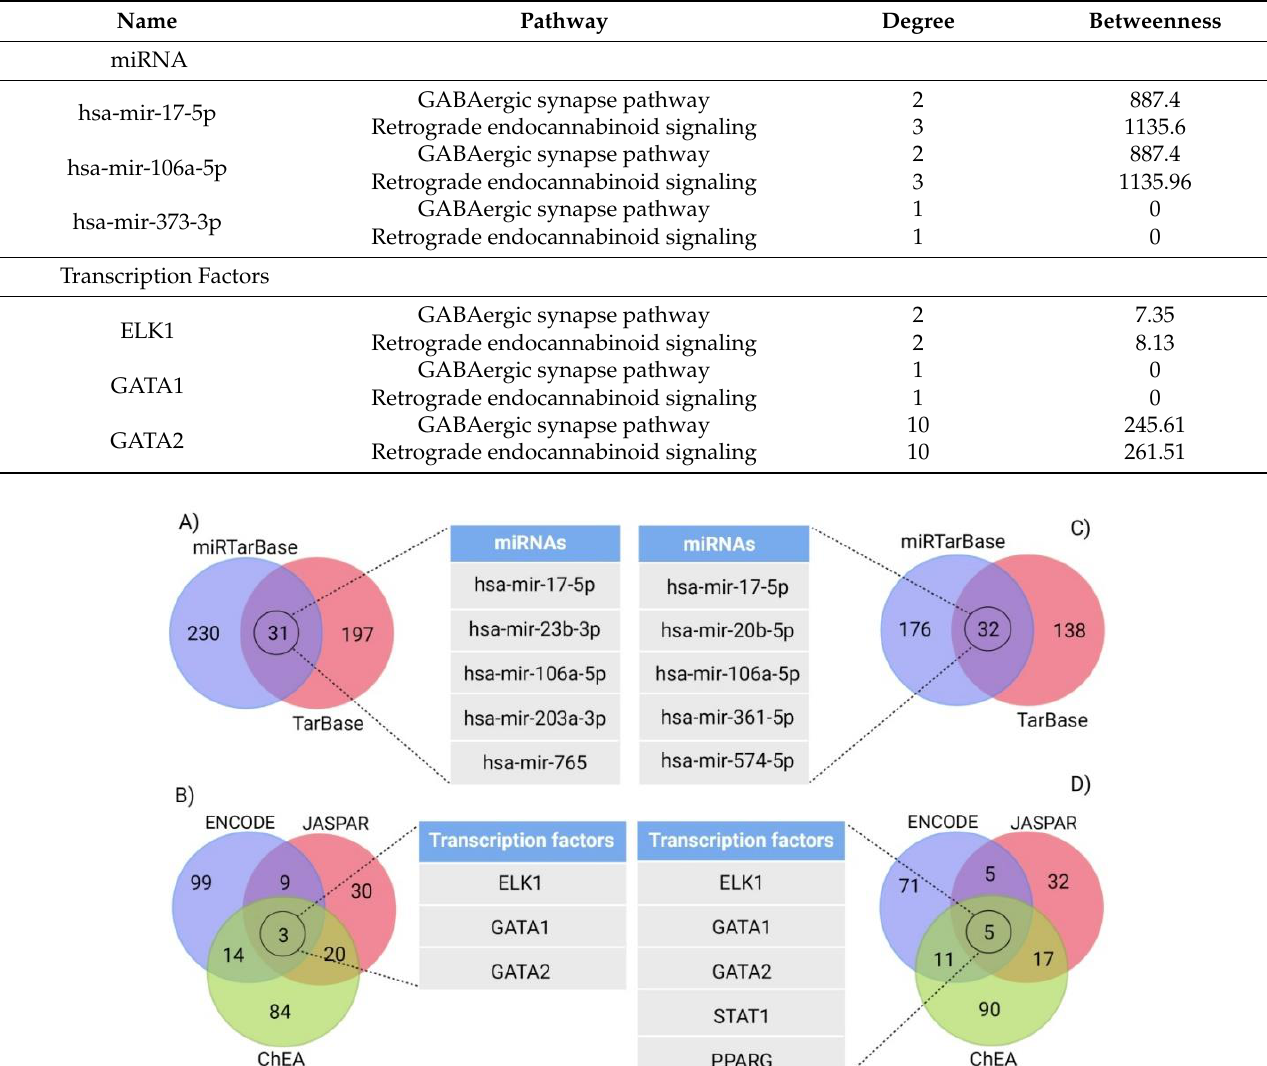
Table 3. The top three shared miRNAs and TFs between the GABAergic synapse pathway and the retrograde endocannabinoid signaling pathway; data were extracted from miRTarBase and JASPAR databases.